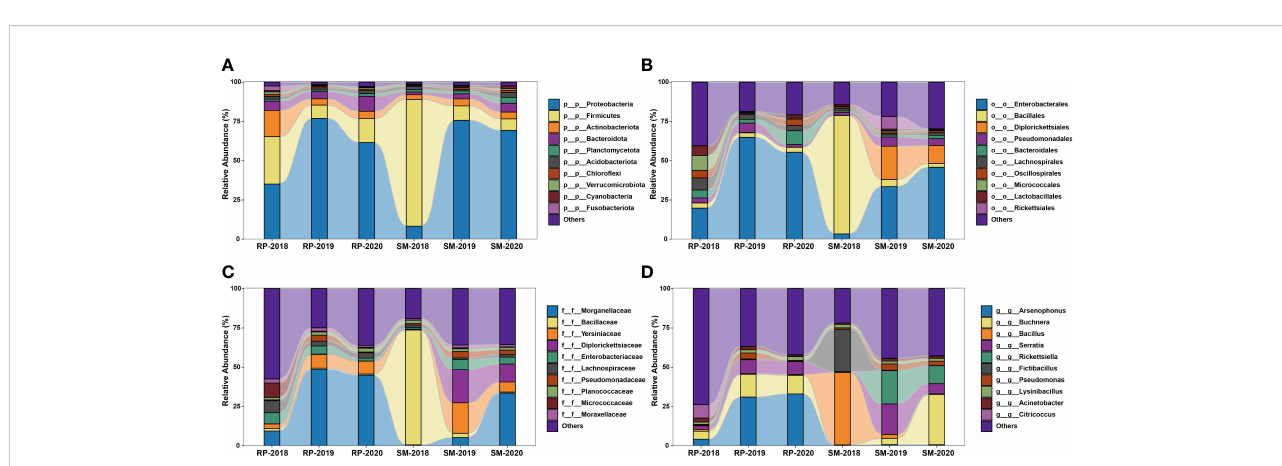
FIGURE 6 Stacked bar plot showing the relative abundance of the top 10 bacterial taxa identi fi ed in Sitobion miscanthi and Rhopalosiphum padi samples at four taxonomic levels. (A) , phylum; (B) , order; (C) , family; and (D) ,